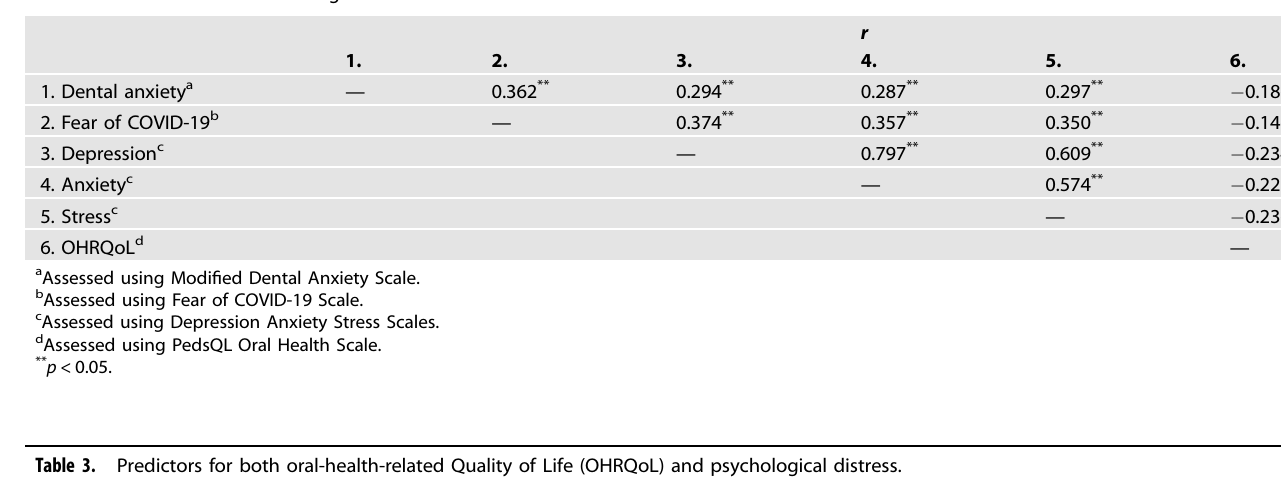
Table 2. Correlation matrix among tested variables.